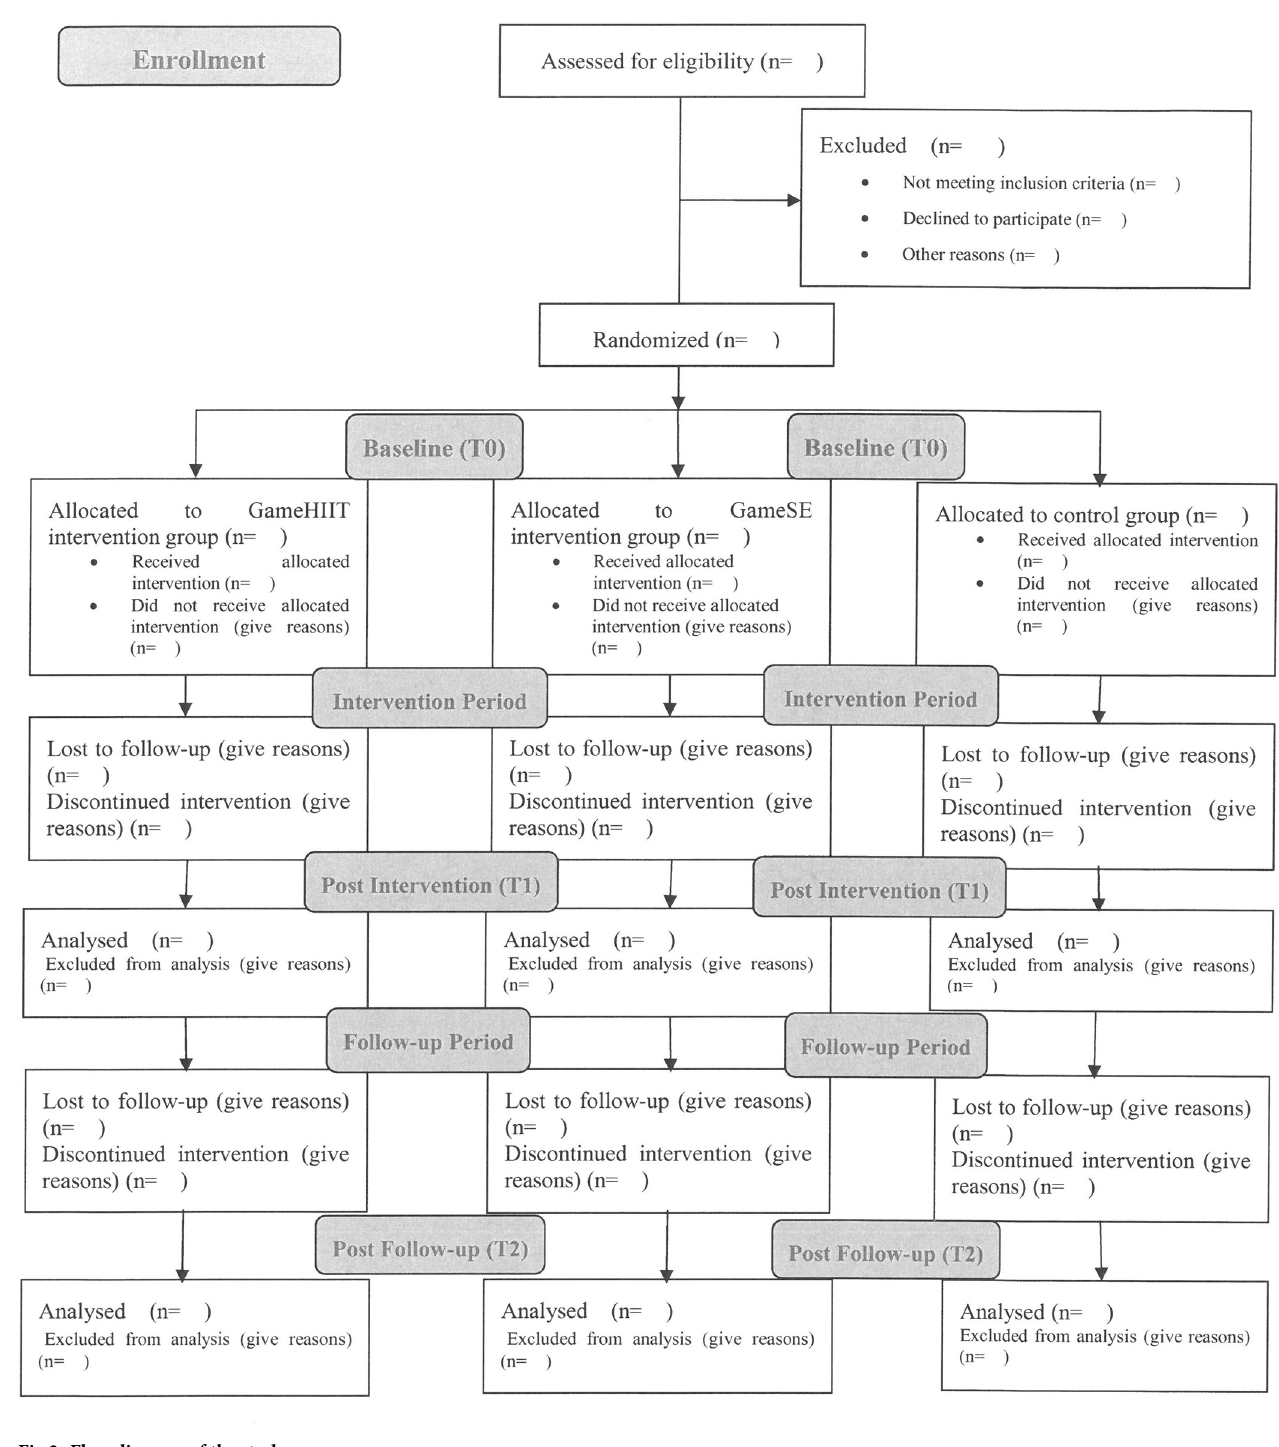
hemodynamic response, weekly PA levels, physical fitness, feeling state, and enjoyment and adherence to the intervention. All assessments will be conducted by trained research staff blinded to group allocation. To ensure the accuracy and consistency of the measurements, a